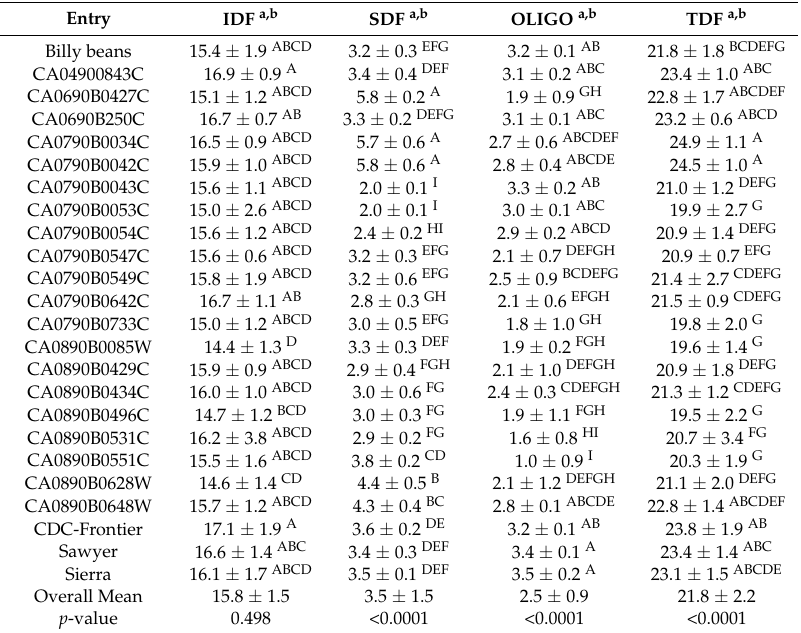
Table 1. Dietary fiber content of chickpea cultivars and breeding